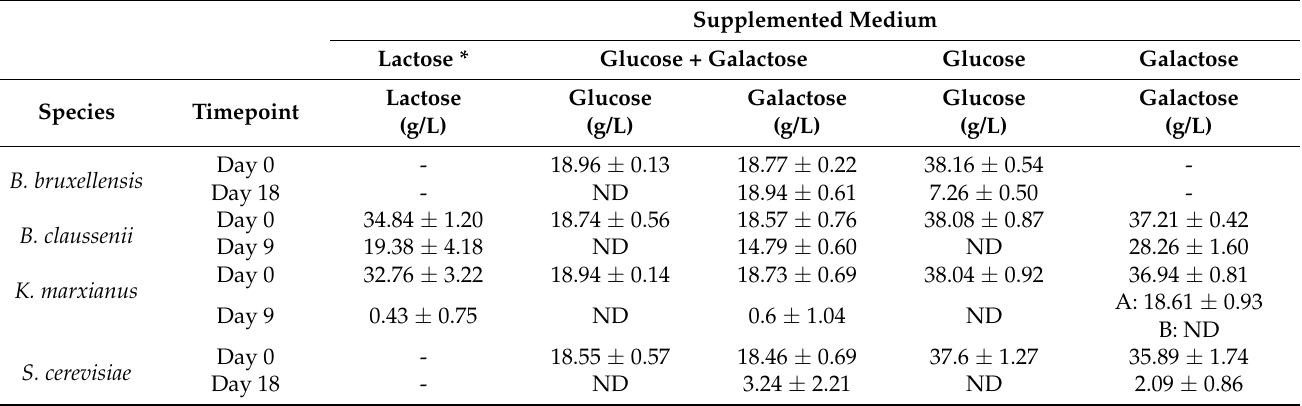
Table 1. For K. marxianus in GAL, the two observed trends are presented as separate results. Table 1. Initial and final concentrations of fermentable carbon sources in fermentates containing sugars associated with acid whey; fermentates were held at 25 ◦ C and subjected to shaking at 185 rpm. Means and standard deviations are provided, representing biological triplicates, with the exception of values associated with K. marxianus , for which a fourth replicate was included in the experiment. Supplemented Medium Lactose * Glucose + Galactose Glucose